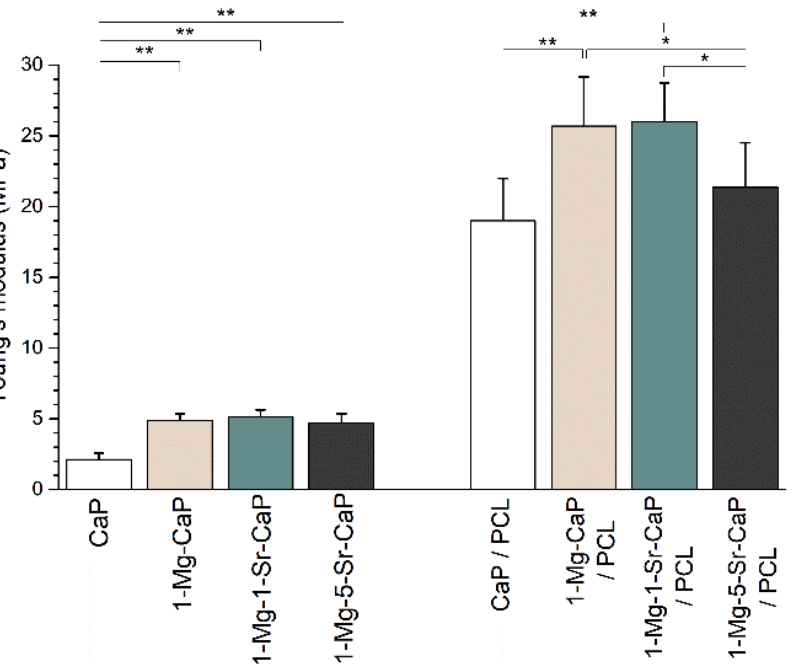
Figure 7. Young’s modulus of unsubstituted (CaP), ion substituted uncoated scaffolds (1-Mg-CaP, 1-Mg-1-Sr-CaP and 1-Mg-5-Sr-CaP) and corresponding coated scaffolds (1-Mg-CaP/PCL, 1-Mg-1- Sr-CaP/PCL and 1-Mg-5-Sr-CaP/PCL) . At least nine replicas of each scaffold were tested and devia- tions are presented with error bars. The significant difference between two groups: * p < 0.05; ** p < 0.01.